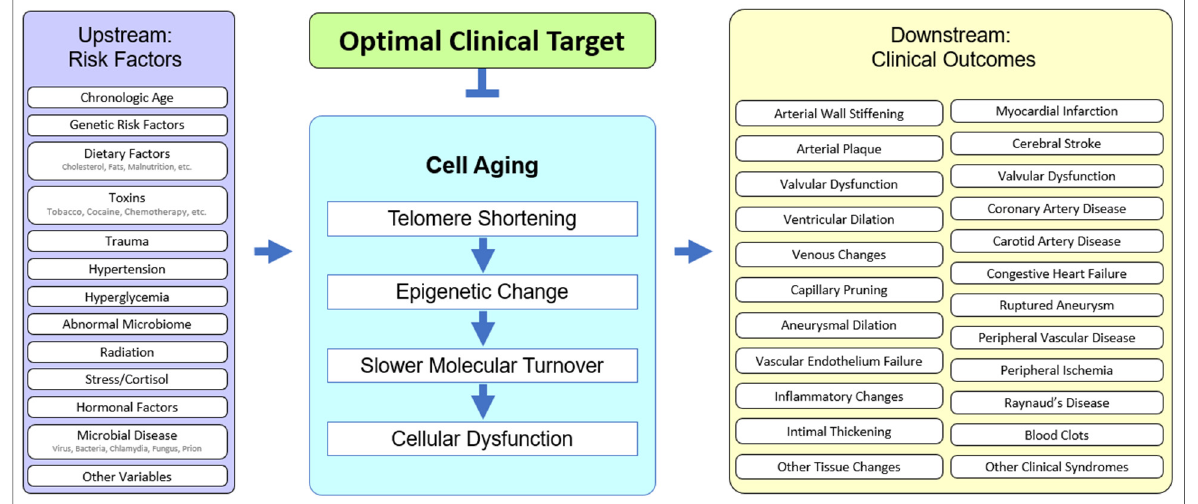
Figure 2. The unified model of cell aging being central to age-related cardiovascular disease. Up- stream risk factors provide variable starting points, affect cell aging, and result in variable downstream clinical outcomes, suggesting an optimal point of intervention.